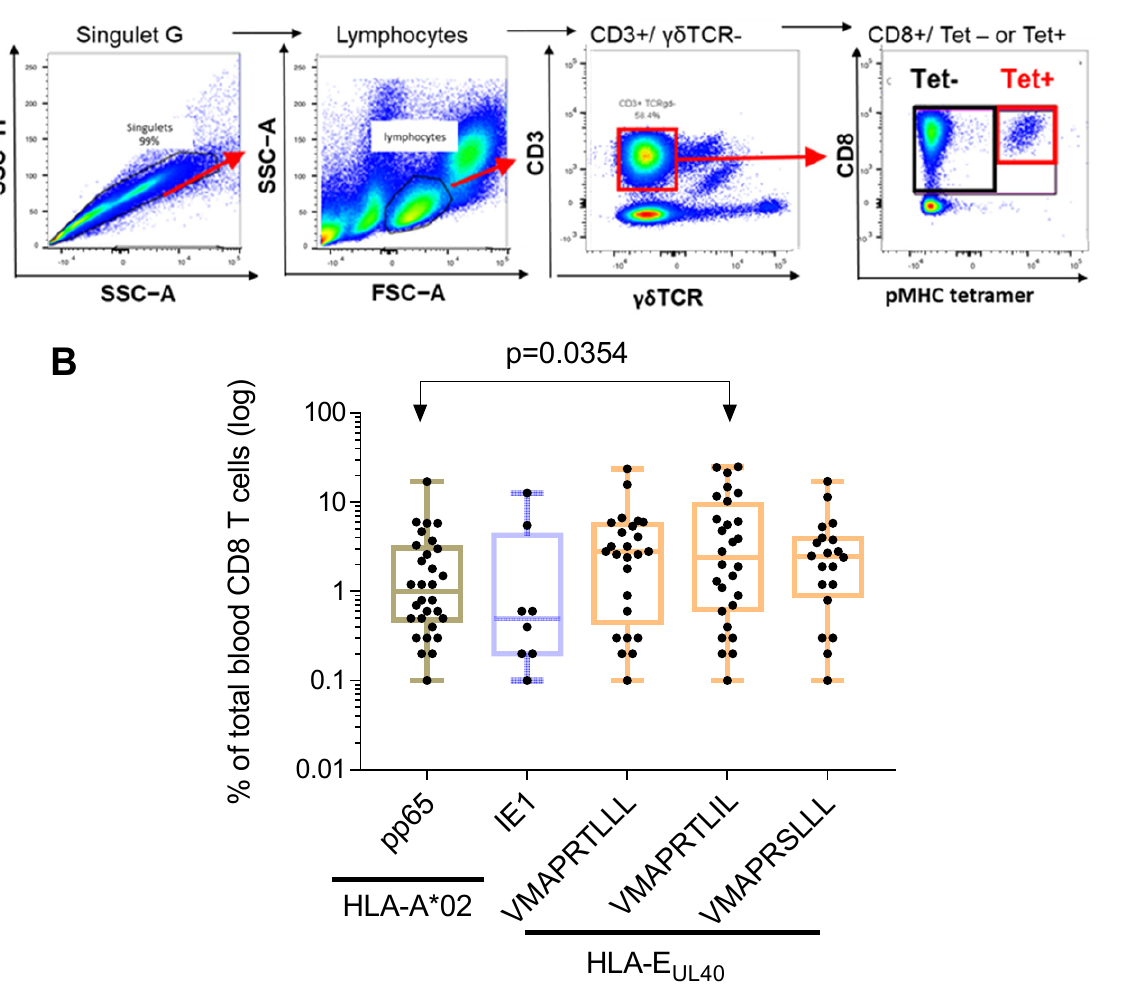
Figure 3. Frequency distribution of HCMV-specific CD8 T cells among total blood CD8 T cells in healthy HCMV+ adults. ( A ) Gating strategy for flow cytometry analysis. Serial steps of cell selection to identify and quantify pMHC tetramer positive (Tet+) are indicated. ( B ) Scatter plots reporting the frequency of A2/pp65, A2/IE1 and E/UL40 CD8 T cells in blood samples from HCMV+ HD with at least one CD8 T response ( n = 60). Data are expressed as percent of total blood CD8 T cells for each HD. Medians and IQR are shown. Each dot corresponds to a single, independent, CD8 T cell subset. Statistical analysis was performed by Mann–Whitney U